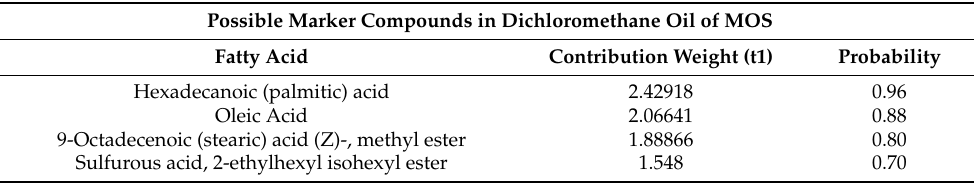
Table 3. Summary of Chemometric analysis of DCM extracted MOS oil.